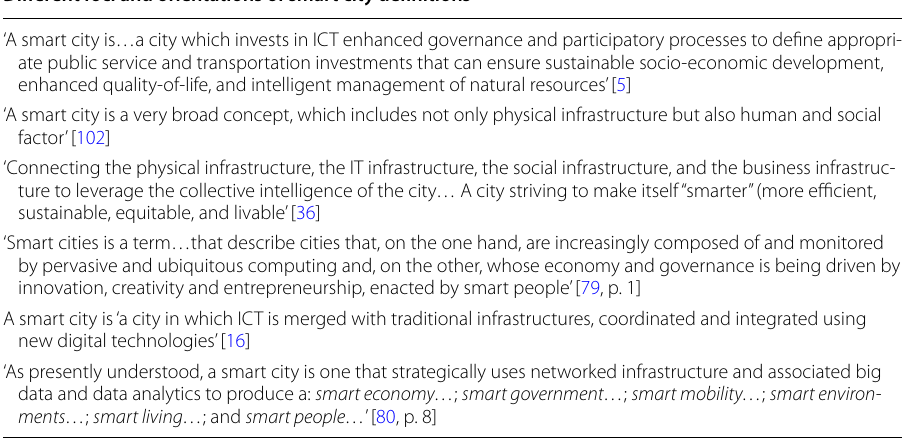
Table 1 Definitions of smart cities Different foci and orientations of smart city